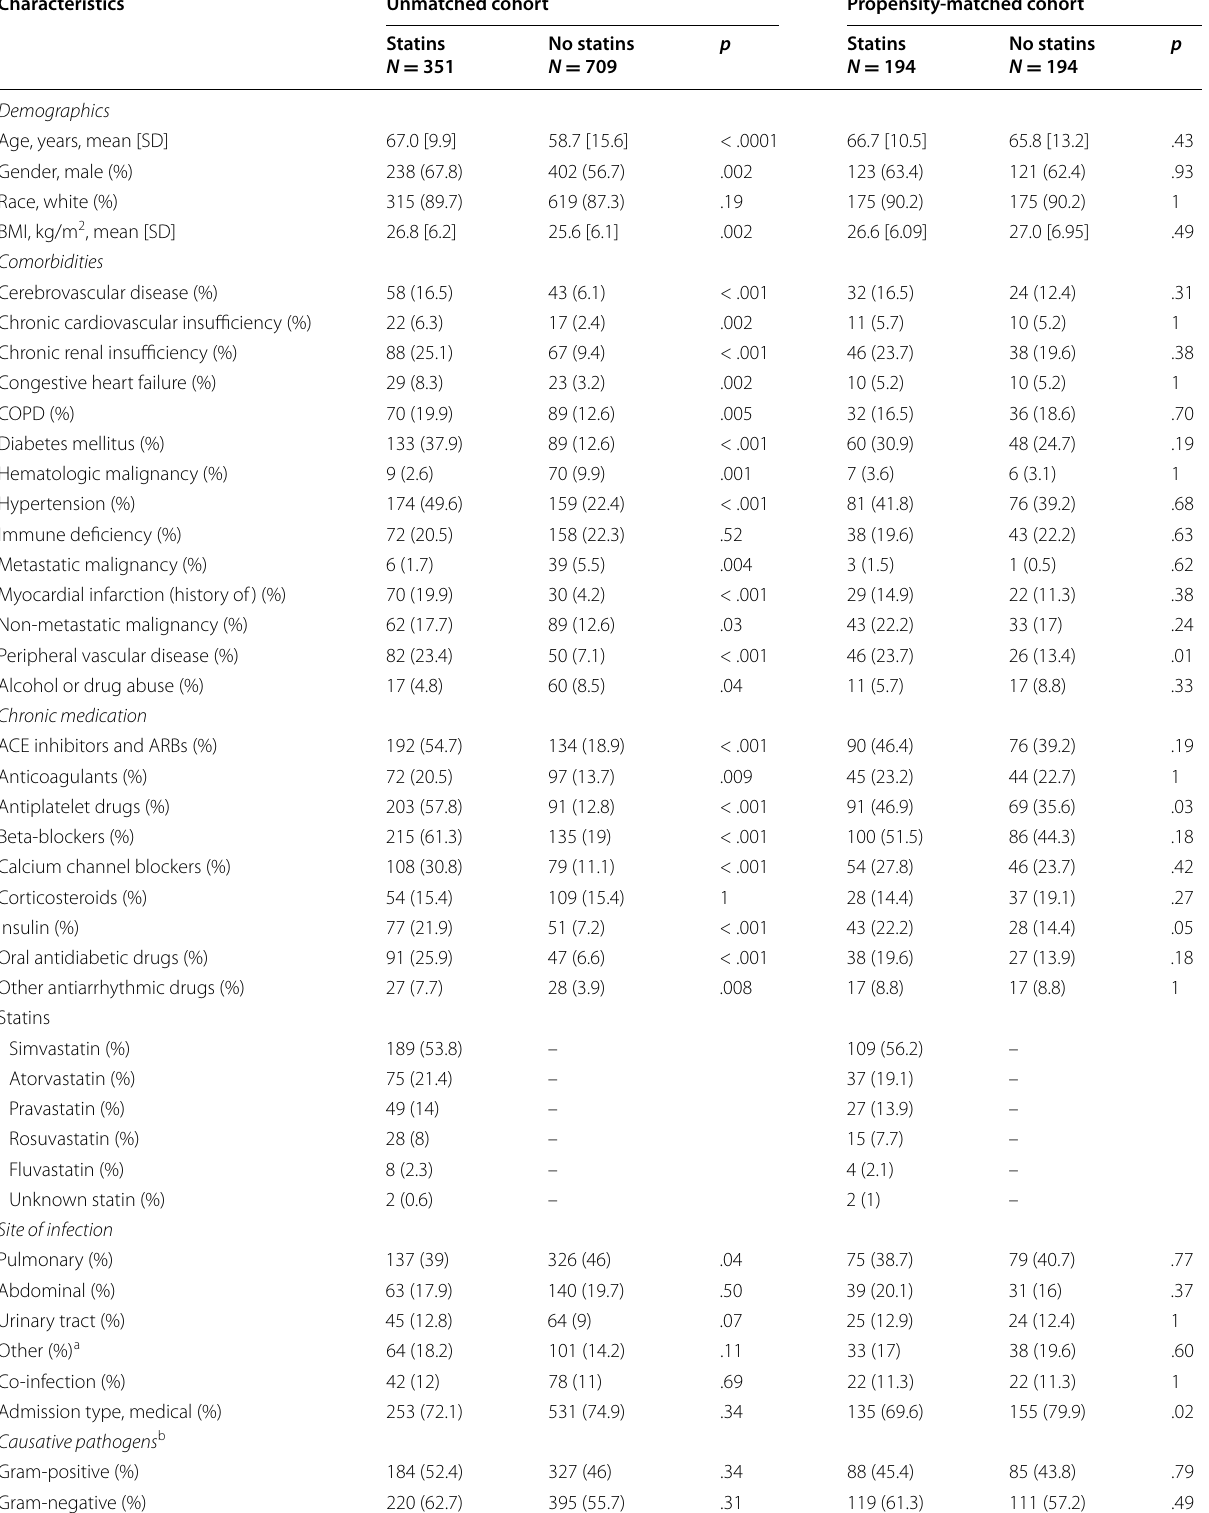
Table 1 Baseline characteristics of sepsis patients admitted to the ICU stratified according to prior use of statins